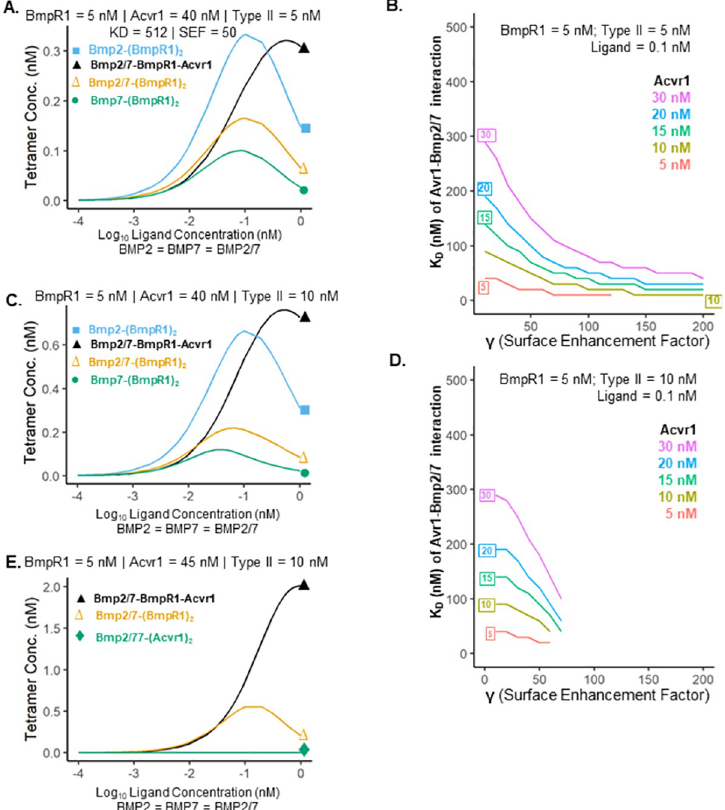
Fig 3. Heterodimer-heterotetramer prevalence under different conditions. A. Shows the distributions of the complexes as a function of ligand concentration in a system with excess Acvr1. The level of BmpR1 receptor complexes exceeds the level of Bmp2/7-Acvr1-BmpR1-(Type II) 2 except for a narrow band from ~.4nM to 1 nM. B. The weakest possible Acvr1 –Bmp2/7 binding affinity in which Bmp2/7-Acvr1-BmpR1-(Type II)2 is the most prevalent receptor tetramer at a ligand concentration of 0.1 nM. Recall that higher K D (nM) indicates weaker binding affinity. C-D. Same as A and B with higher amounts of Type II receptor in the model. E. In the Bmp2/7-only system with 10nM type II receptor, 9-fold excess Acvr1 leads to greater heterodimer-heterotetramer complex formation over a wide range of ligand concentration.